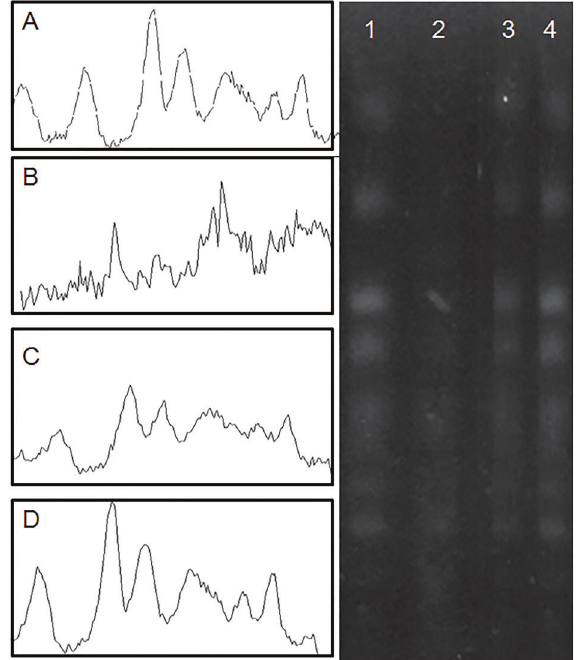
Figure 6. Densitograms (left) corresponding to samples shown in the right photograph from the SC7K lys2-3 strain. Comparative absorbance (Y-axis) as a function of distance (X-axis). A : control sample; B : g irradiated sample; C : g + rutin treated sample, and D : g + Ilex paraguariensis sample. Right panel: Chromosomal DNA gel photograph of treated and control cell samples after pulsed fi eld electrophoresis. From left to right: 1: control sample; 2: g irradiated sample; 3: g + rutin treated sample; 4: g + Ilex paraguariensis